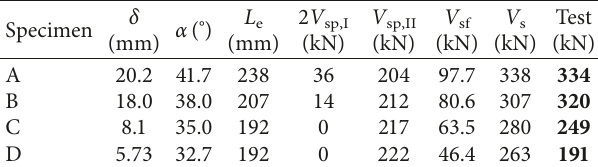
Figure 13: Envelope curves of test and predicted curves for (a) specimen A and (b) specimen B. Table 3: The predicted shear capacity of the